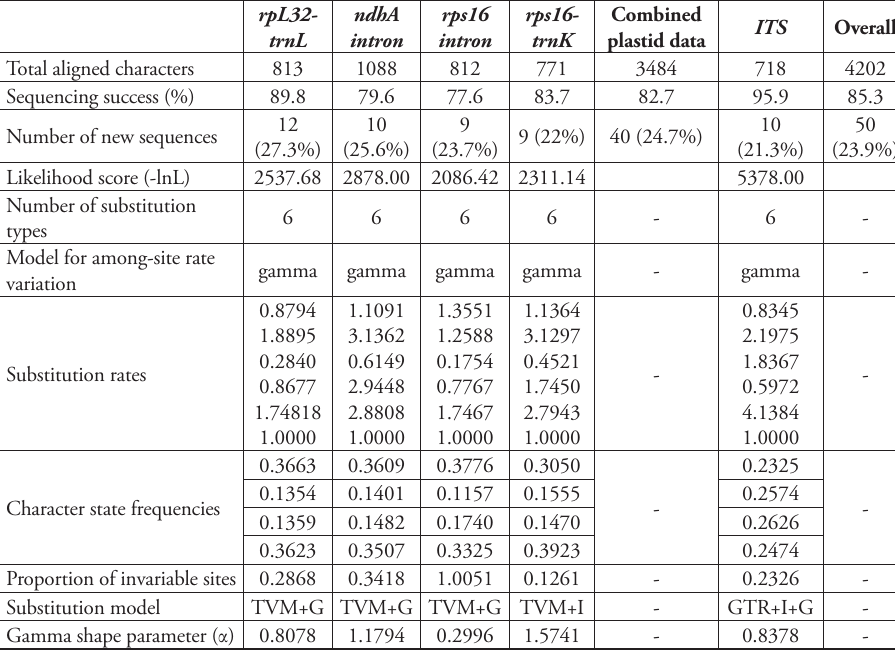
Table 2. Characteristics of the five regions, rpL32-trnL, ndhA intron, rps16 intron, rps16-trnK and ITS, and parameters used in Bayesian analyses indicated by Akaike Information Criterion